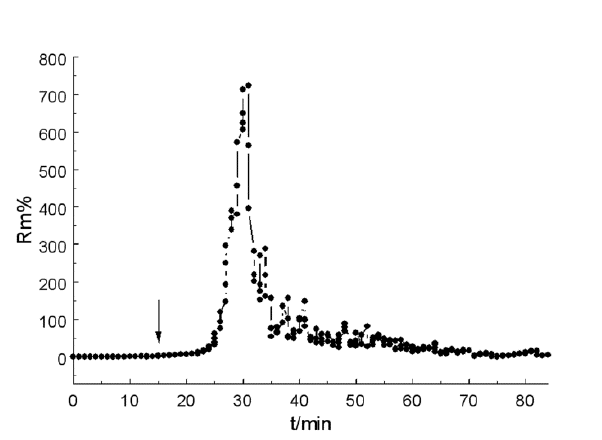
Fig. 4: Plot of the Rm% as a function of time using glucose as the carbon source. The black arrow indicates the addition of